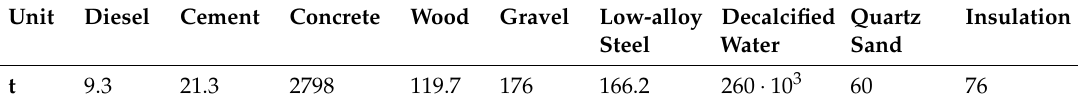
Table 3. Materials used for the “static” part of a geothermal station in t.